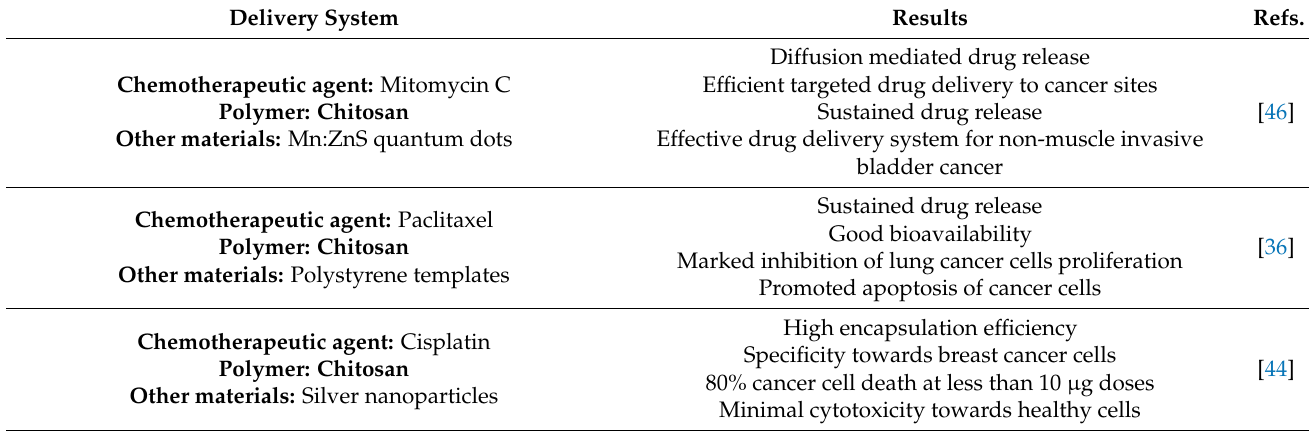
Table 2. Polymer-based delivery nanosystems for chemotherapeutic agents.